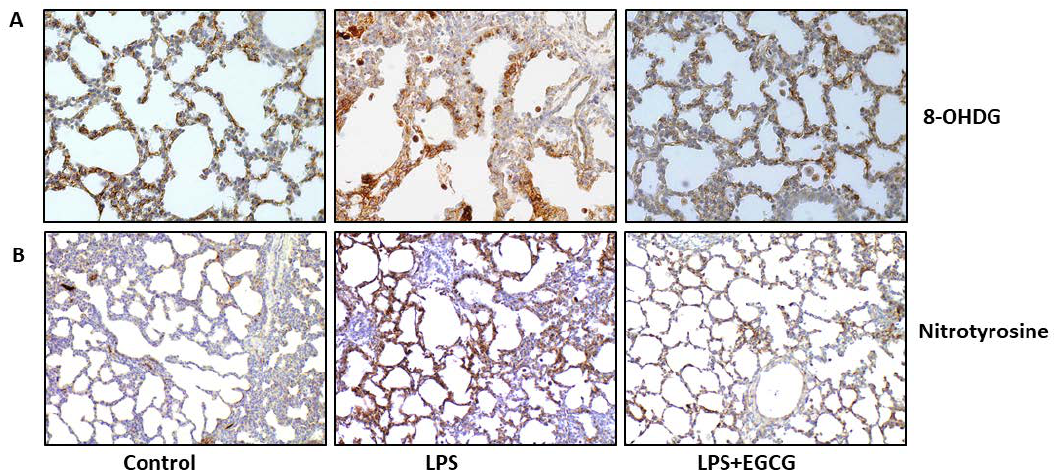
Figure6. EGCGalleviatedoxidativestressinLPS-inducedALI.( A Figure 6. EGCG alleviated oxidative stress in LPS-induced ALI . ( A ) The lung 8-OHDG protein expression shown by immunohistochemistry in the different study groups (10× objective). EGCG